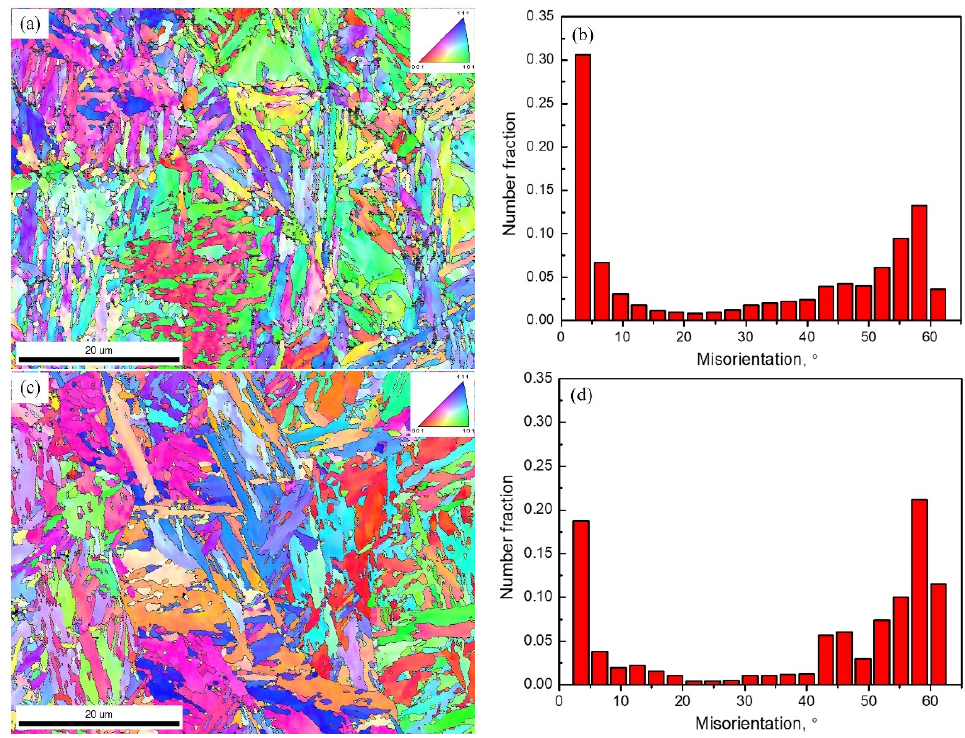
Figure 6. EBSD microstructure characterization for the sample of 1.54Si-60s ( a , b ), the sample of 1.26Al-60 s ( c , d ): Orientation image (left) and misorientation angle distribution (right).